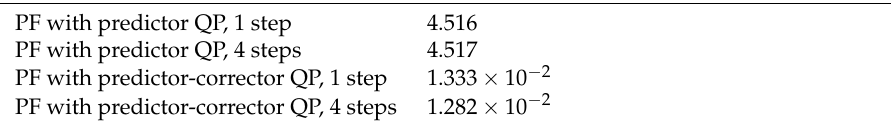
Table 3. Approximation error using path-following algorithms. asNMPC, advanced-step NMPC (asNMPC); QP, quadratic programming.